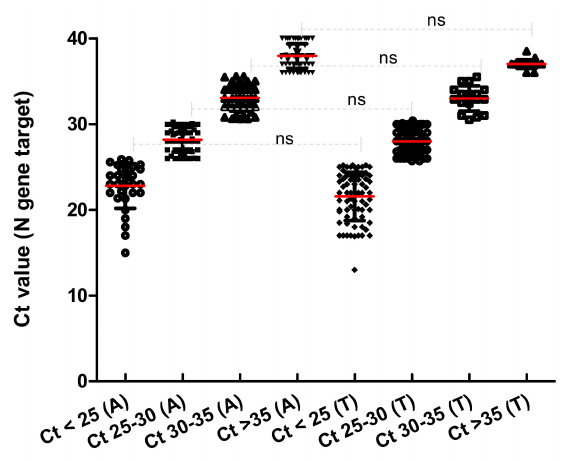
Figure 3. Comparison of Ct groups data from Allplex™ 2019-nCoV (A) TaqPath™ COVID-19